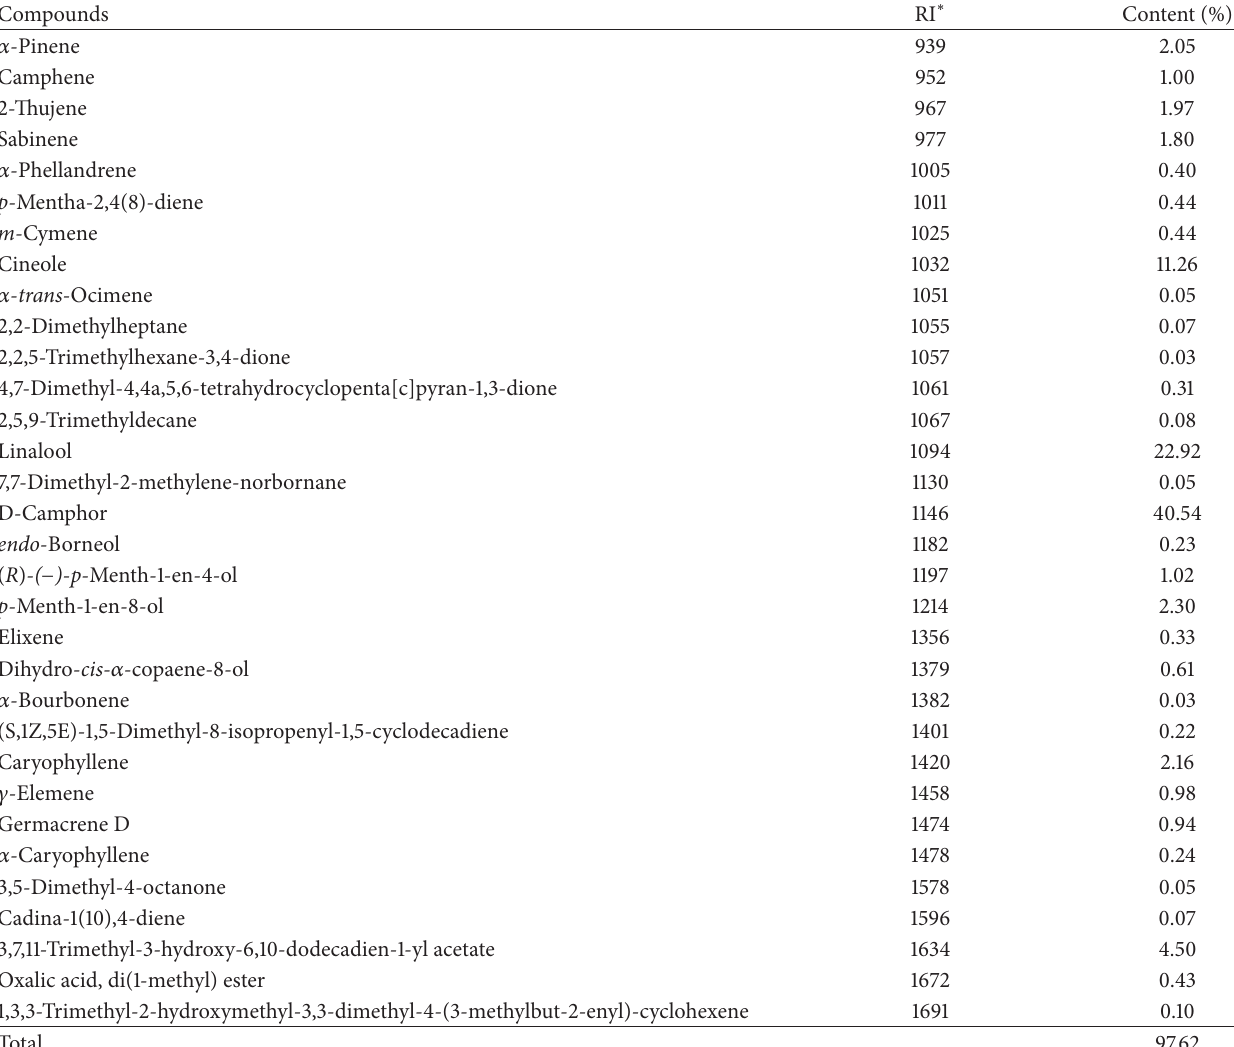
Table 1: Chemical composition of the essential oil of Cinnamomum camphora